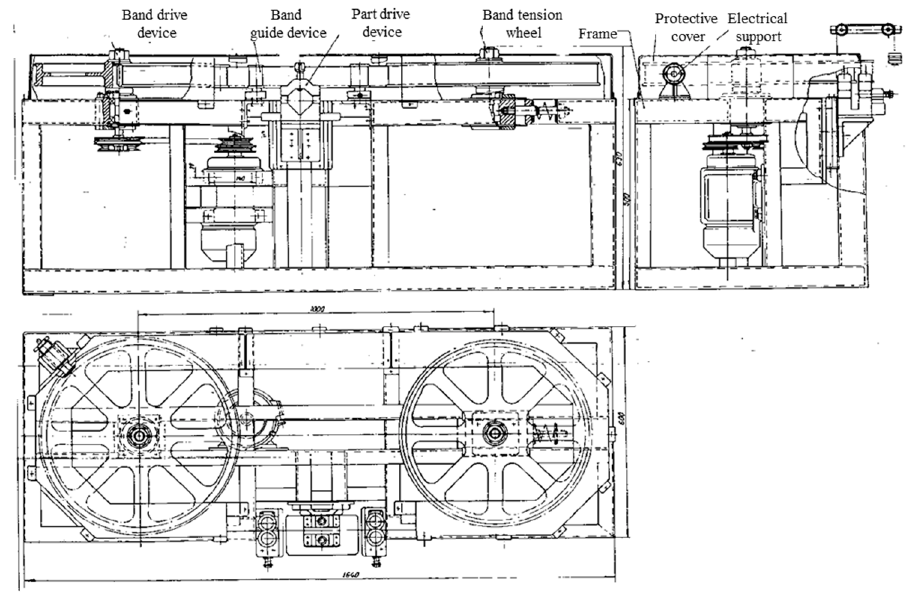
Figure 11. The experimental stand assembly.